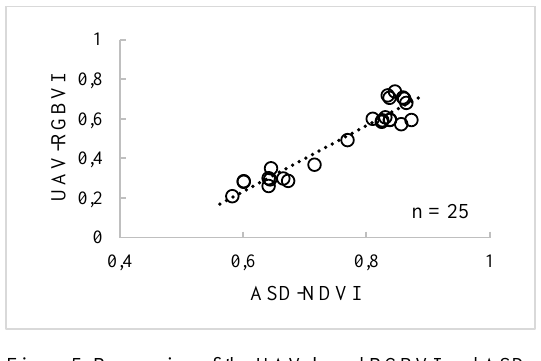
Figure 5. Regression of the UAV-based RGBVI and ASD Fieldspec3-based NDVI per plot for the first sampling date (02.04. & 06.04.2014, ASD & UAV respectively).